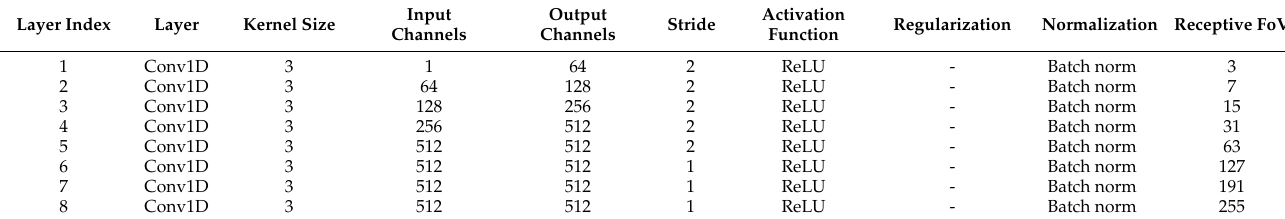
Table A2. CNN architecture that is used for the FSL approach.